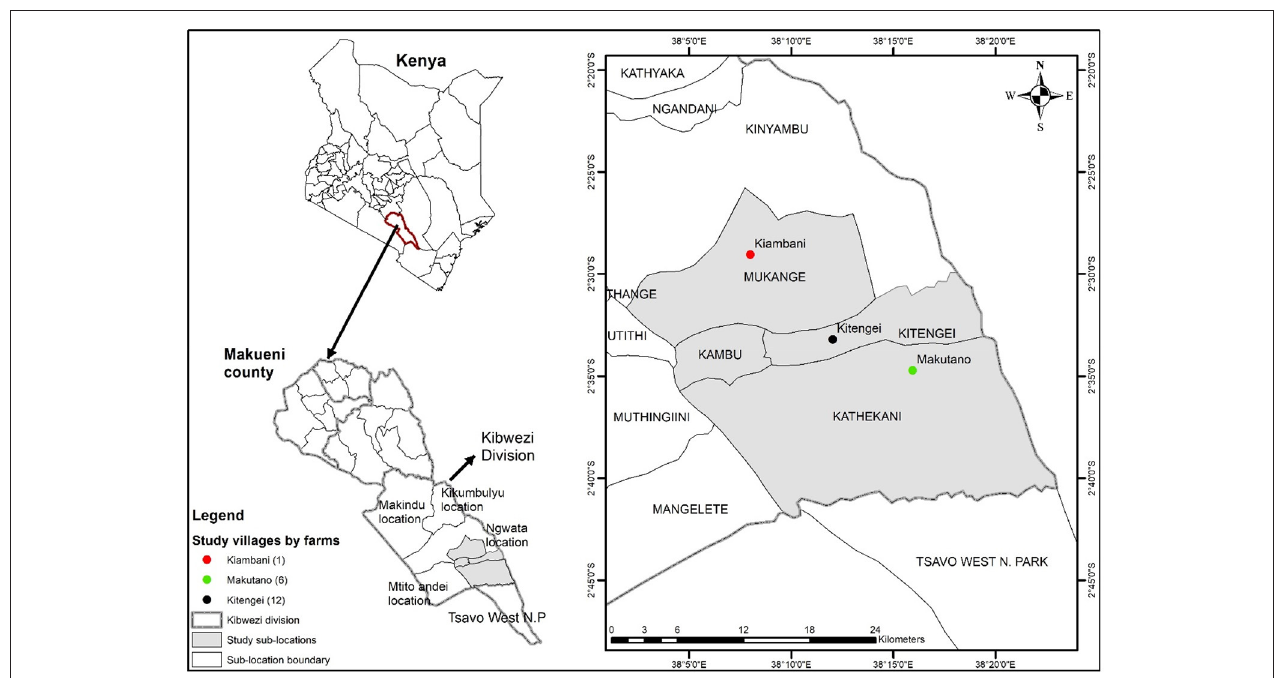
FIGURE 1 | Maps of Makueni County, south-eastern Kenya, showing the location of (left) study sub-locations in the county (shaded area) and (right) on-farm experiments (colored dots) in Kiambani, Kitengei, and Makutano.